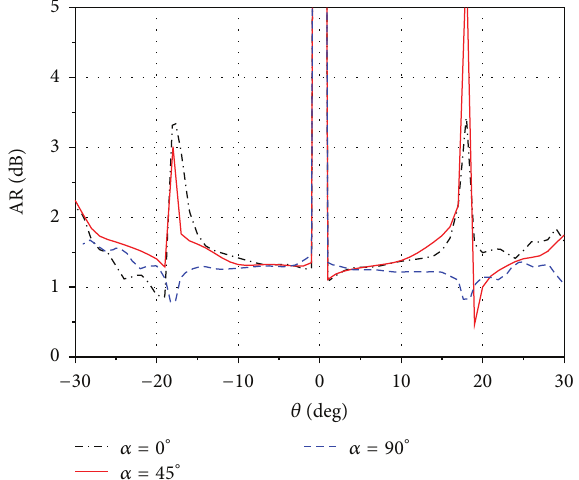
Figure 13: The AR of OAM state ℓ = −1 for right circular polarization.